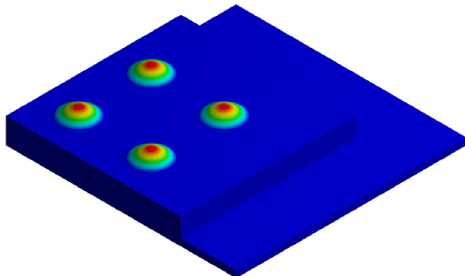
Figure 11. Fundamental electro-mechanical displacement mode shape of the stand-alone device 93.0 kHz (3 V bias), 85.5 kHz (10 V